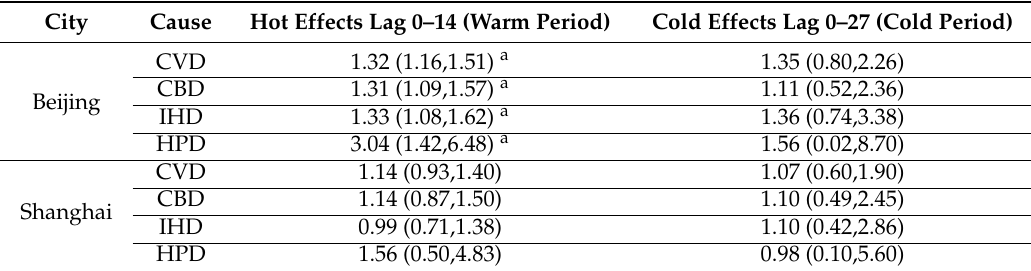
Table 5. The cumulative hot effects during the warm period at lag 0–14 and cold effects during the cold period at lag 0–27 days in Beijing and Shanghai,